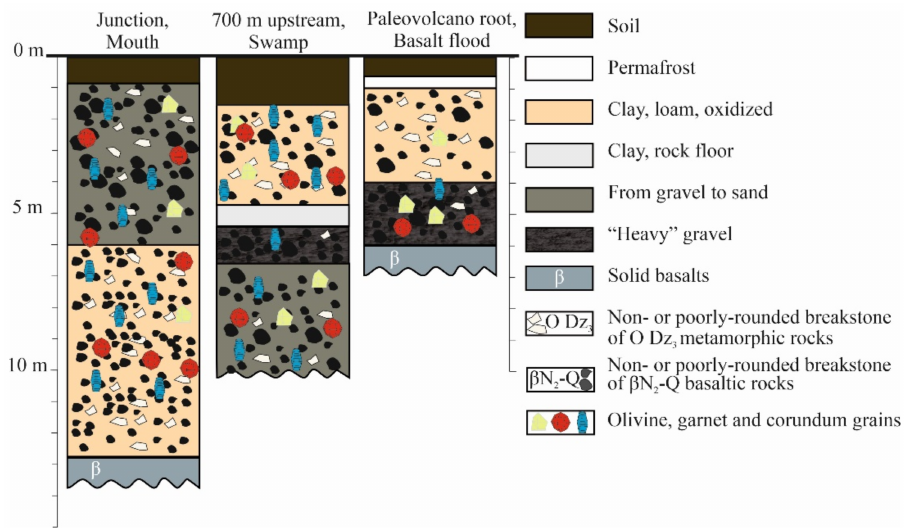
Figure 3. Composition charts of 3 trenches (7 to 15 m deep): root, swamp, and